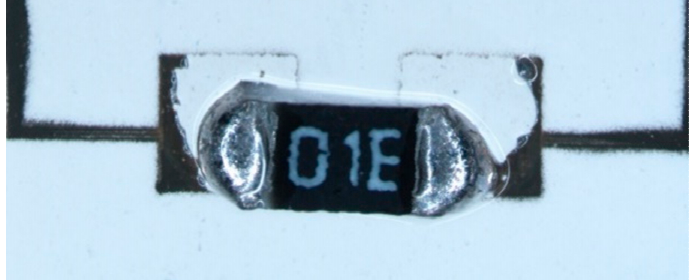
Figure 11. Aerosol jet printed Ag structures with 12 printed layers (ink: Sicrys I30 EG-1) on Luxaprint 3D mold after soldering with SnBi solder in reflow oven with 155 °C peak temperature.